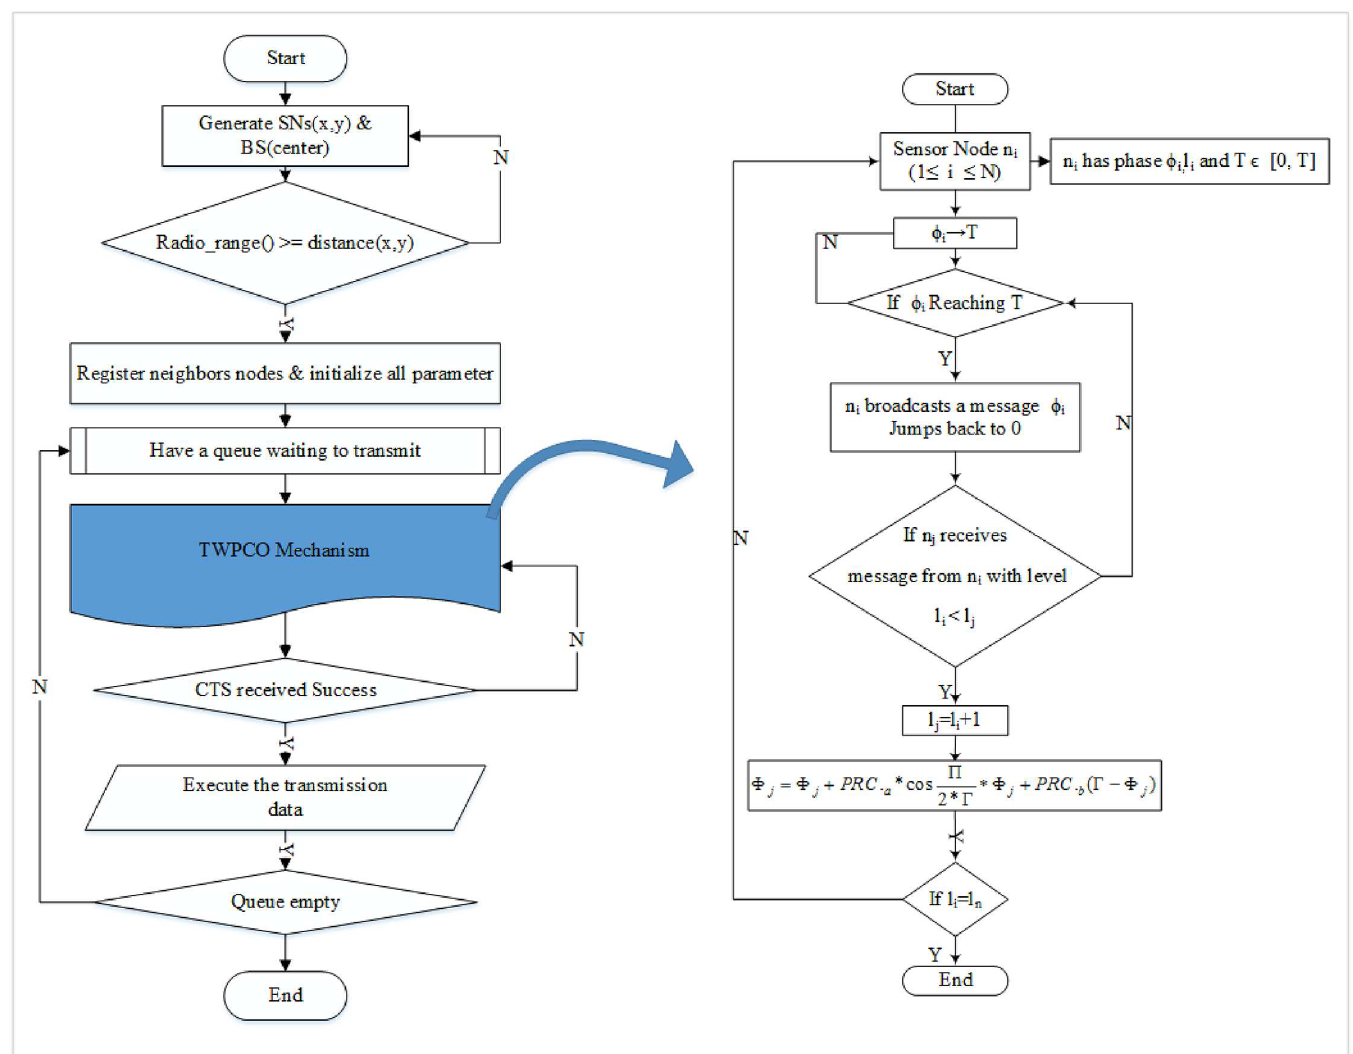
Fig 4. Flowchart of the proposed TWPCO